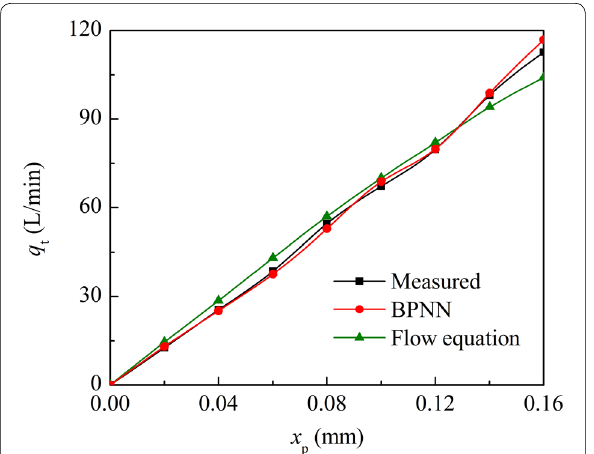
Figure 11 Flow without the flow control method